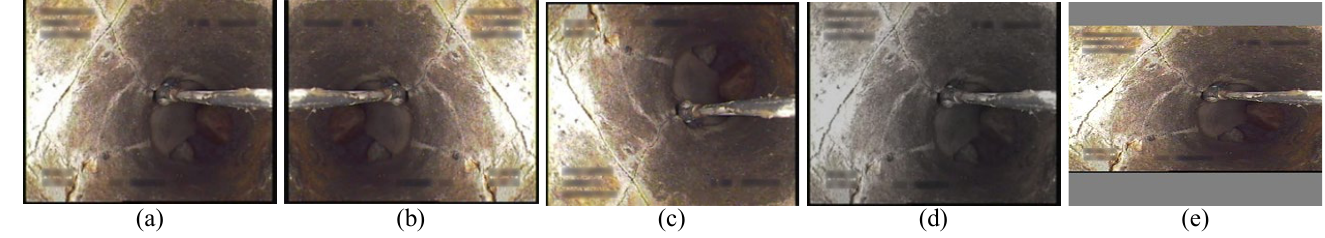
Figure 4. Different types of data augmentation: ( a ) raw image; ( b ) horizontal flip; ( c ) vertical flip; ( d ) color tuning; and ( e ) random scaling.